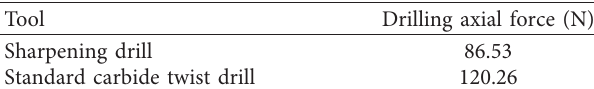
Table 2: Comparison of axis force of the two drills. Tool Drilling axial force (N) Sharpening drill 86.53 Standard carbide twist drill